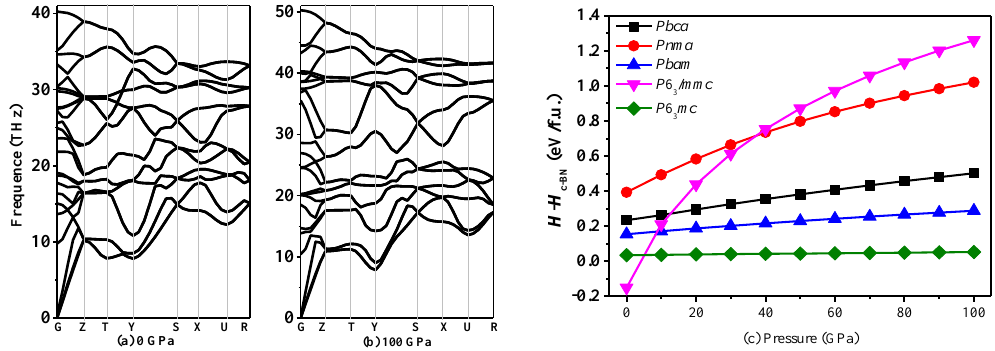
Figure 3. The phonon spectra of Pnma -BN at 0 GPa ( a ) and 100 GPa ( b ); Mixing enthalpy Δ H of BN alltropes calculated using PBE ( c ).